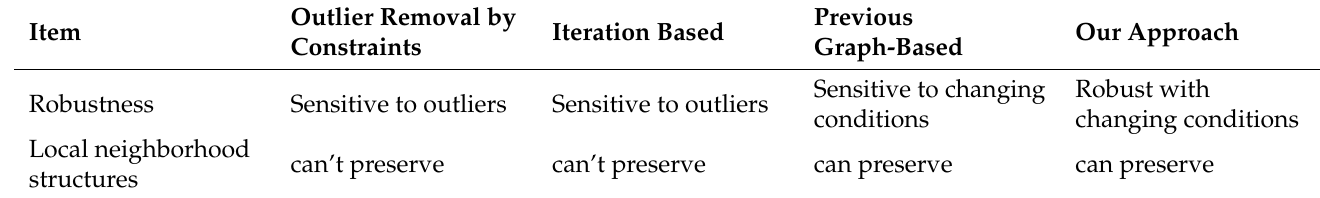
Table 2. Comparative